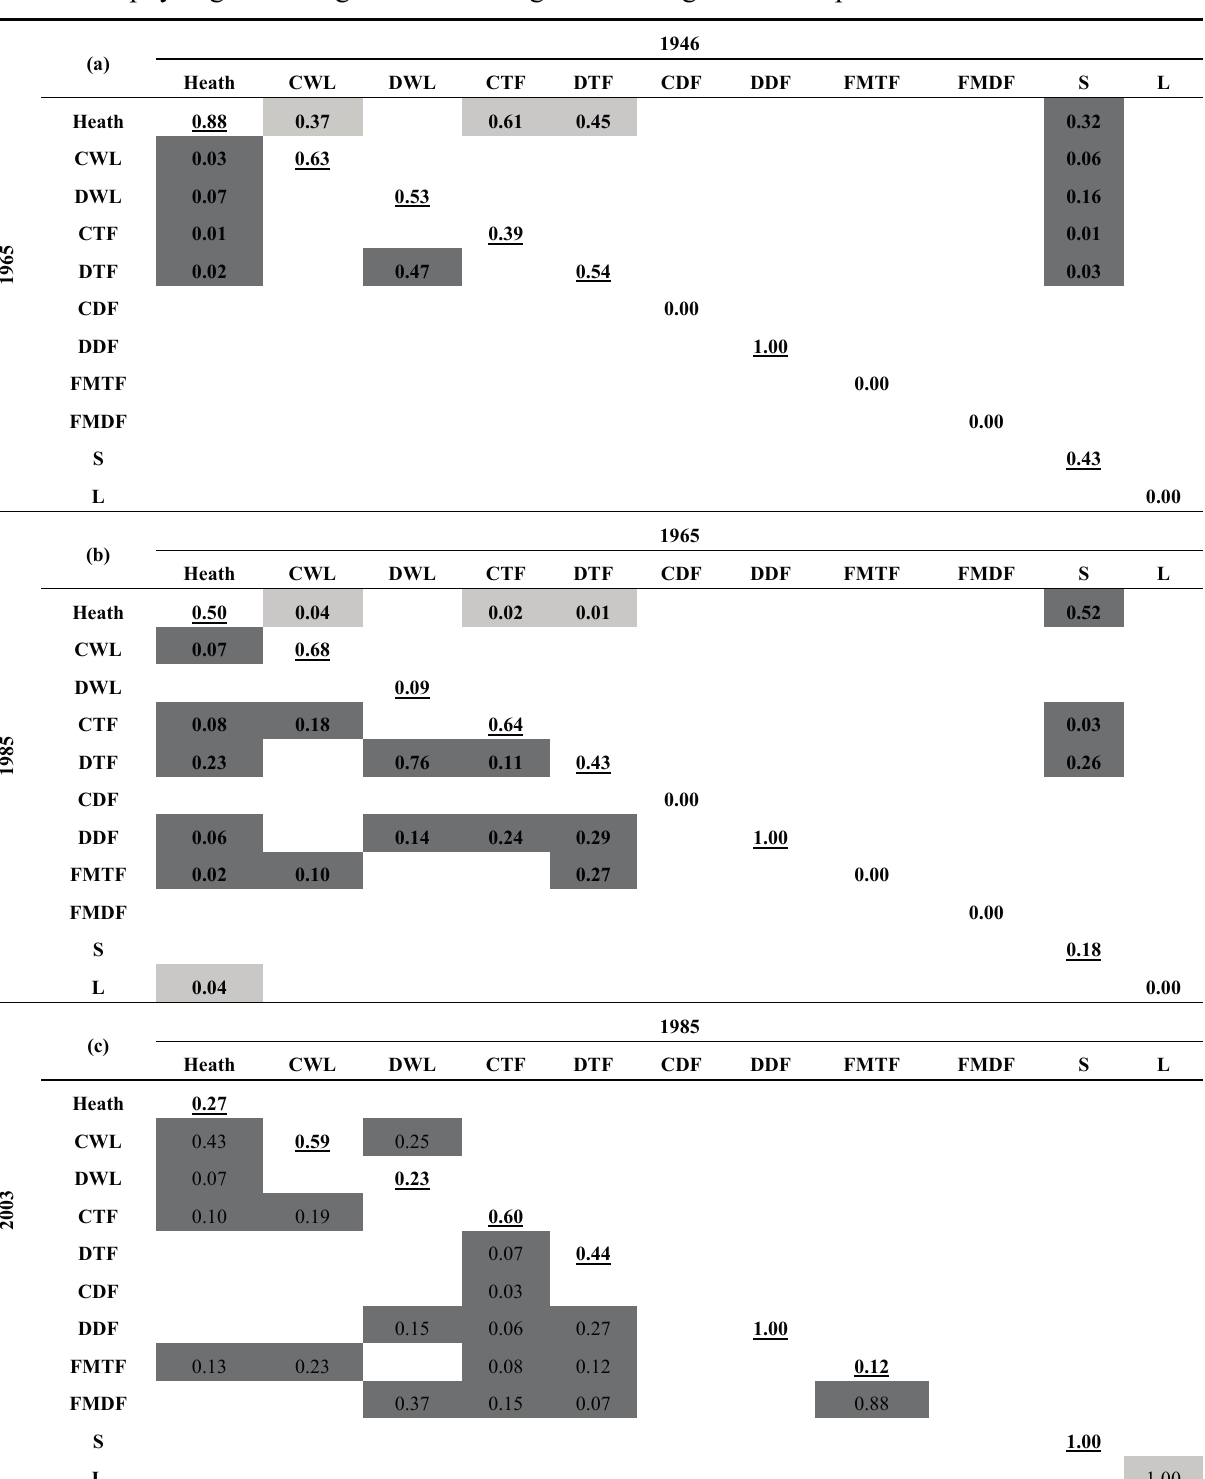
Table 2. Transition matrices with the percentage of change from one stage to the other between the two dates: ( a ) 1946–1965, ( b ) 1965–1985, and ( c ) 1985–2003. The dark grey background represents the progressive transition of heathland to forest, a light grey background represents a regressive transition from forest to heathland related to anthropogenic activities, and underlined values indicate the no-change diagonal line of various physiognomic vegetation. The vegetation categories are explained in Table